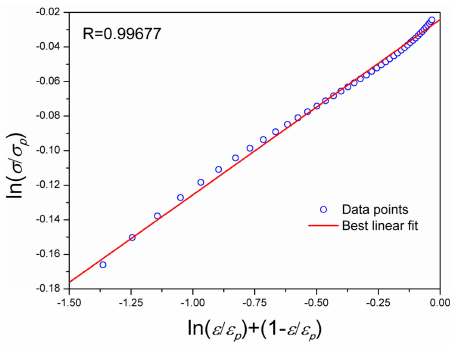
Figure 4. Relation between ln( σ / σ p ) and [ln( ε / ε p ) + (1 − ε / ε p )] in the prior-peak